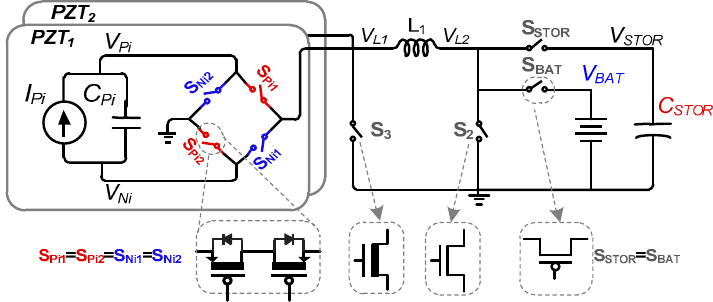
Figure 3. Proposed Dual-PZT energy-harvesting interface circuit.